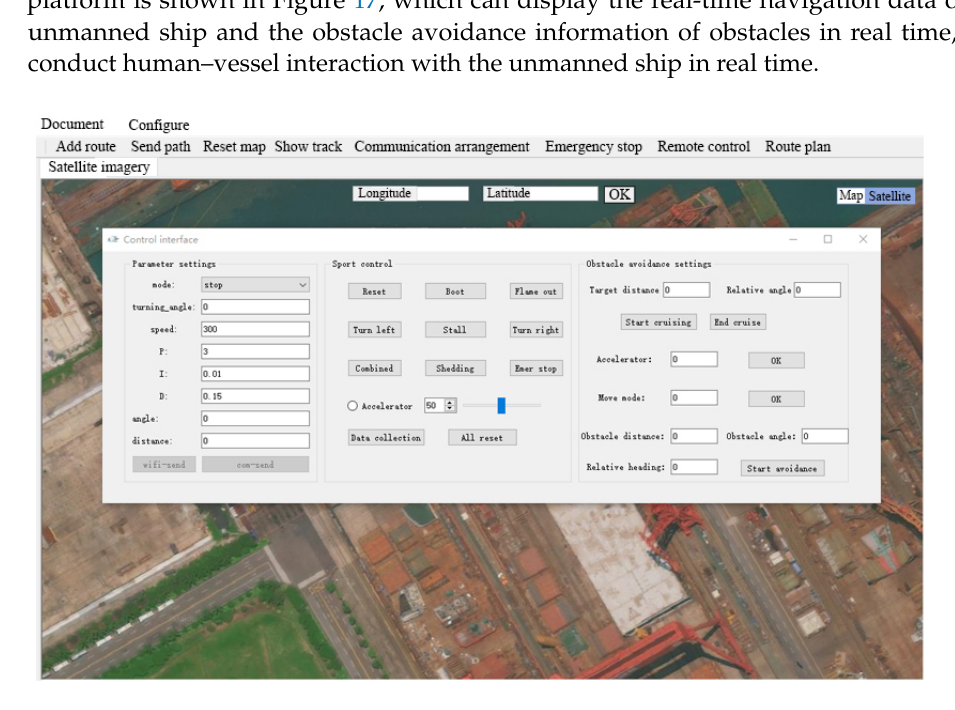
( f ) Figure 18. Obstacle image segmentation results. ( a ) Overwater image of obstacle. ( b ) Region grow- ing segmentation result. ( c ) Automatic multi-seed segmentation result. ( d ) Underwater image of obstacle. ( e ) Region growing segmentation result. ( f ) Automatic multi-seed segmentation result.